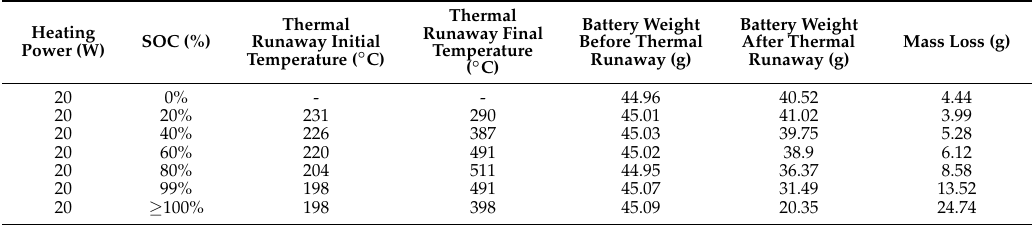
Figure 4. Temperature curves and thermal runaway initial temperature of lithium-ion battery under different SOCs: ( a ) Temperature curves; ( b ) Thermal runaway initial temperature. Table 3. Experimental results of lithium ion battery under different SOC.